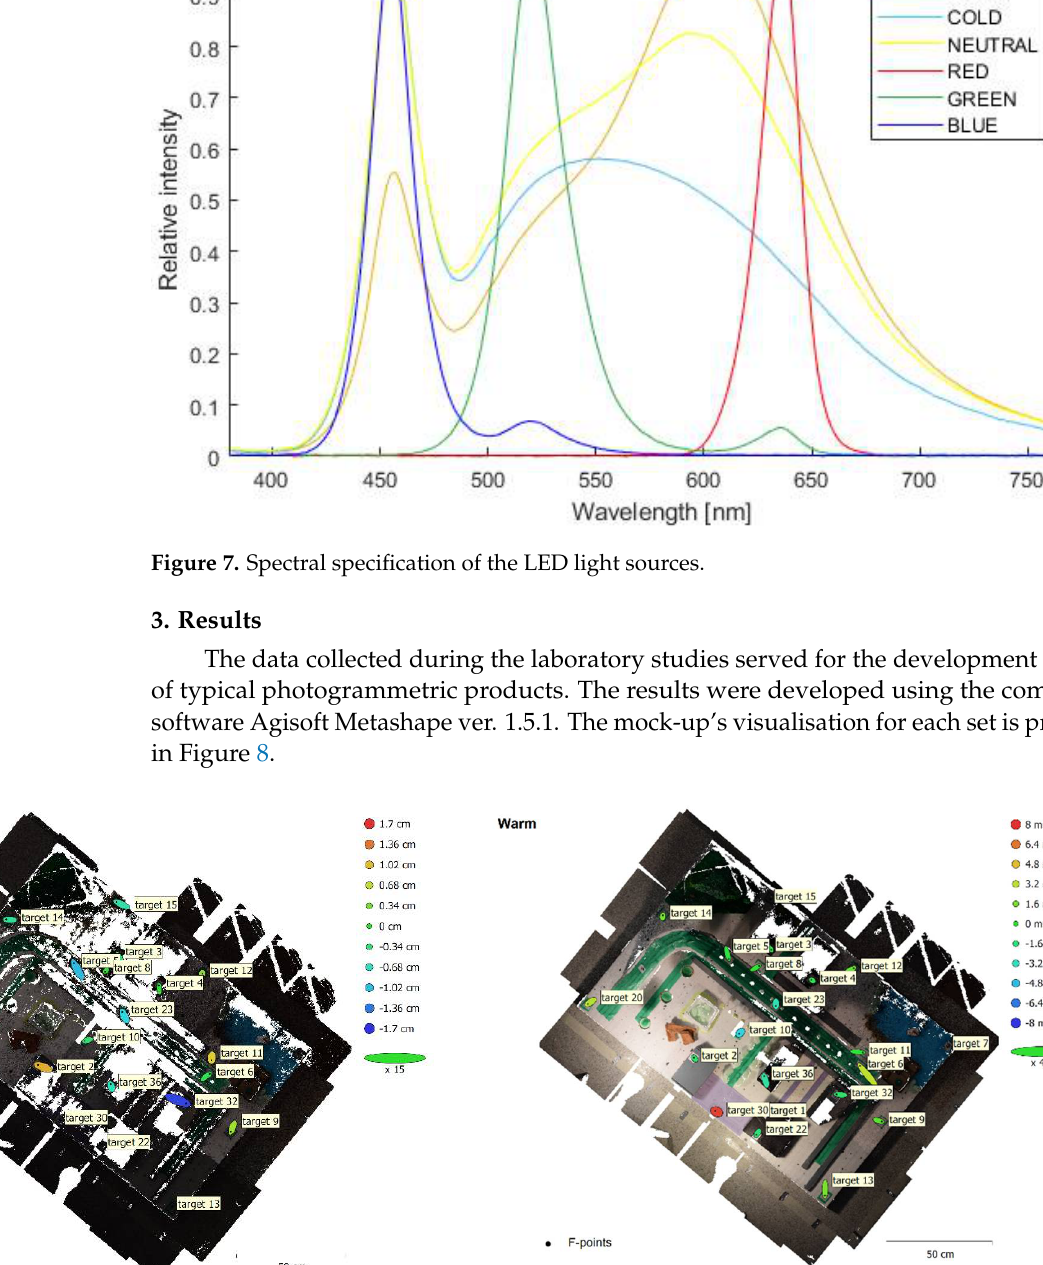
Figure 7. Spectral specification of the LED light sources. Table 3. Photometric values of the LED light sources.